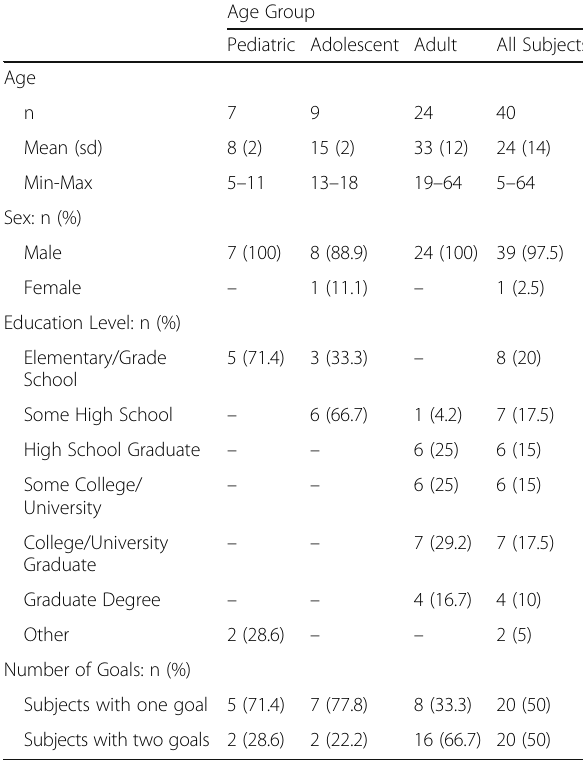
Table 1 Sample characteristics at baseline